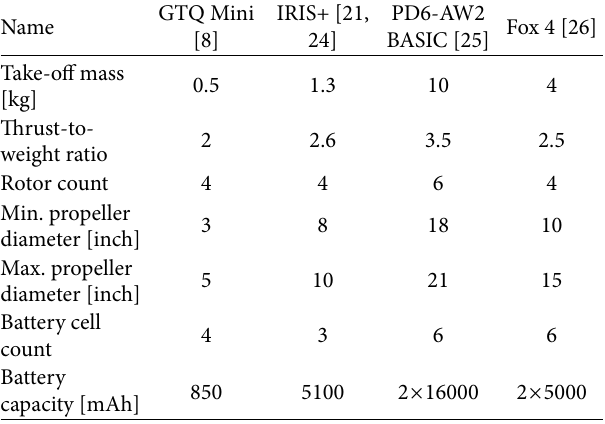
Table 6: Drone parameters used in further testing.